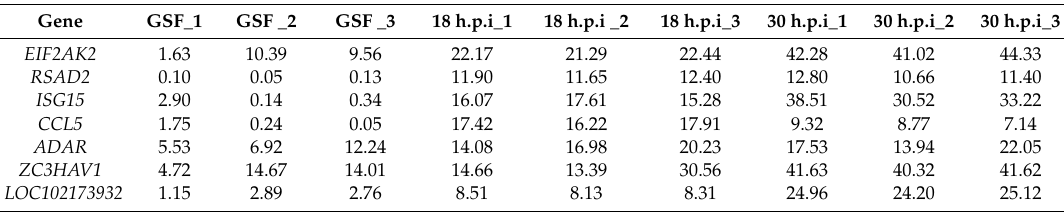
Table 2. DEGs (fold change ≥ 2 or fold change ≤ 0.5, and p ≤ 0.05 ) enriched in “negative regulation of viral genome replication” GO term. The number in the table represents the FPKM of genes in GSF, 18 h.p.i, and 30 h.p.i